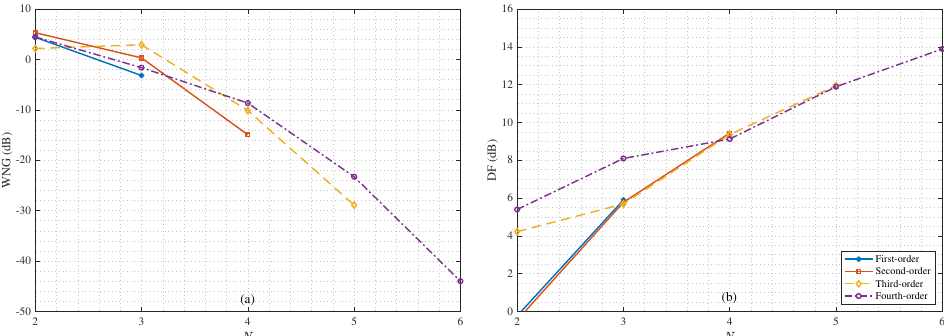
Figure 6. WNGs and DFs of the 1st-, 2nd-, 3rd-, and 4th-order binaural heterophasic superdirective beamformers versus parameter N : ( a ) WNGs and ( b ) DFs. Conditions of simulation: f = 1 kHz and δ = 1 cm.